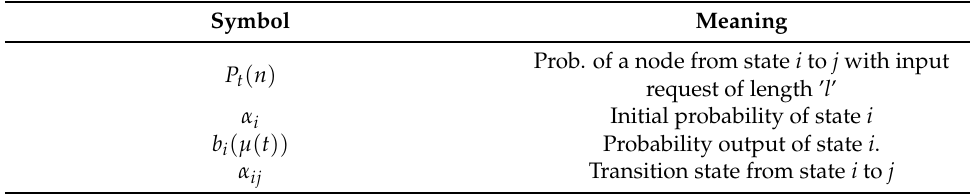
Table 3 represents the abbreviation or notations used to defined Viterbi algorithm. Table 3. Viterbi Algorithm